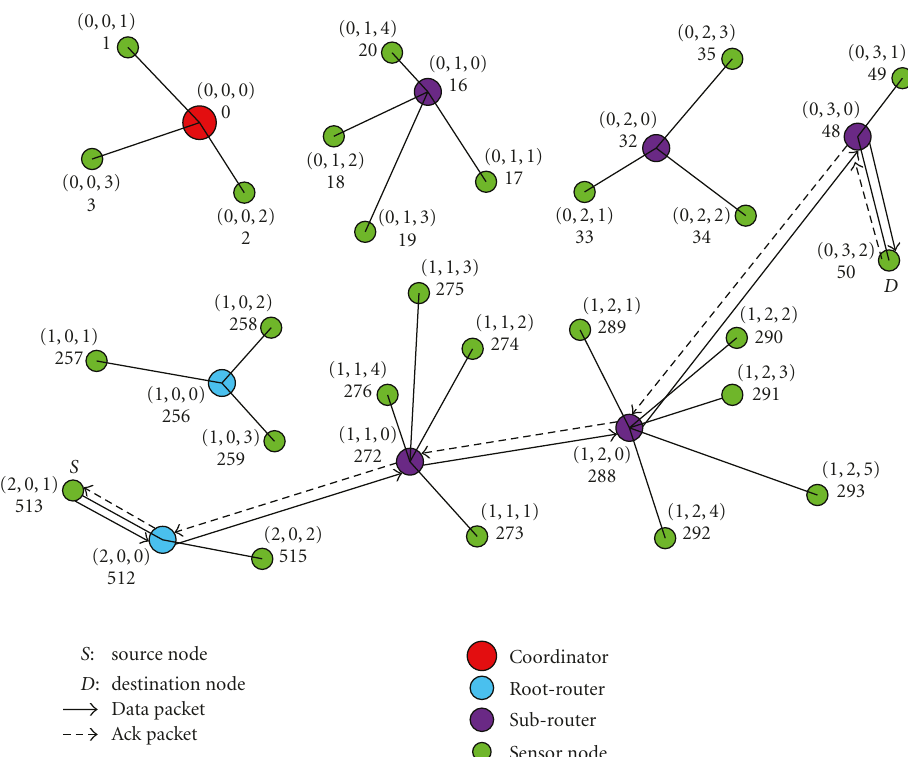
Figure 11: A sample location-aware routing path from (2,0,1) to (0,3,2) for 3D